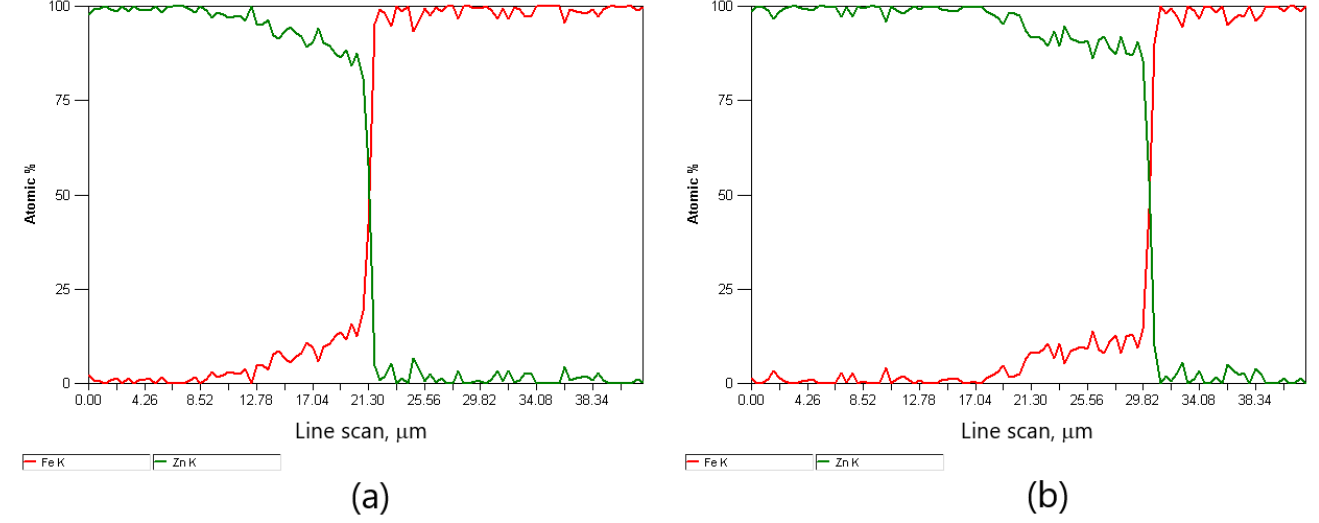
Figure 3. The EDS X-ray spectral analysis in coating micro-areas on the cross-section of the galvanized variant wire ( a ) K5 and ( b ) H5.